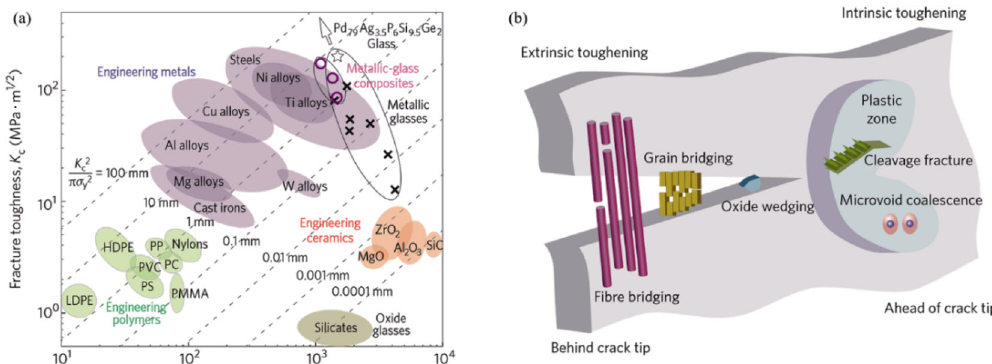
Fig. 6 Conflicts of strength versus toughness: Ashby plot showing strength–toughness relationships for engineering materials (a); schematic of intrinsic versus extrinsic toughening (b). Reproduced with permission from Ref. [145], © Nature Publishing Group, a division of Macmillan Publishers Limited